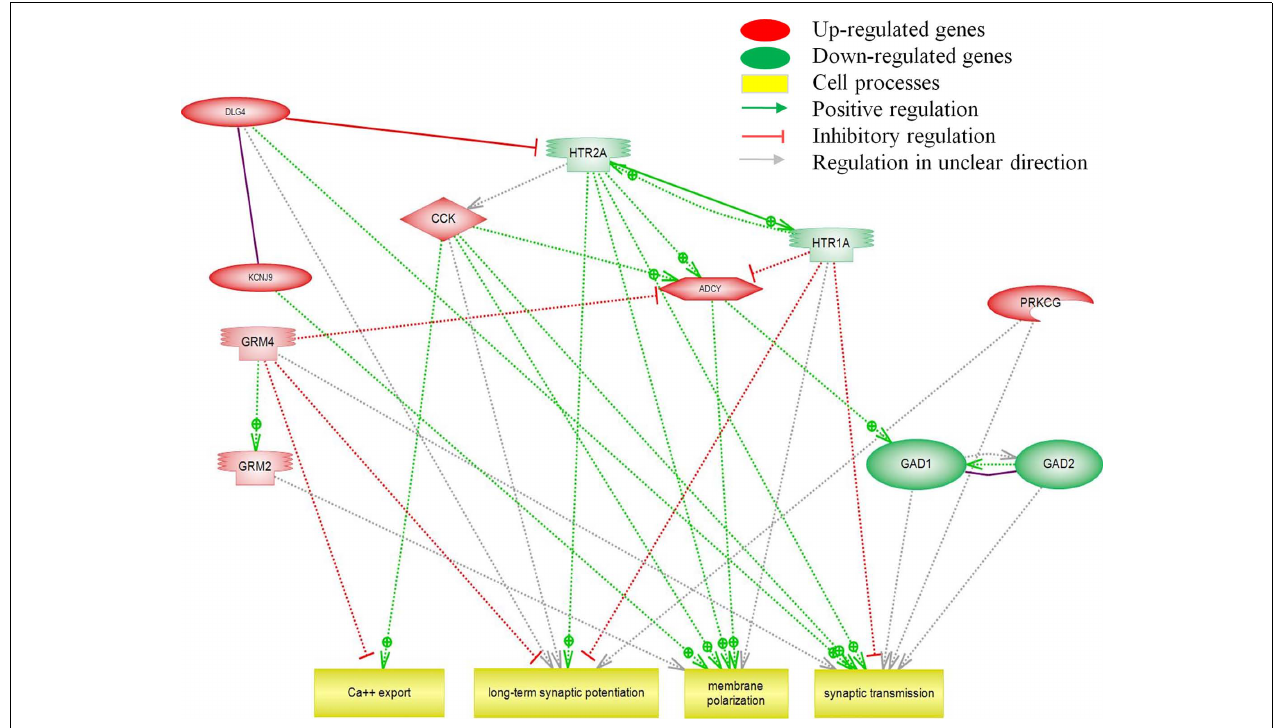
FIGURE 5 | Pathway analysis of transcripts ( p < 0.05) involved in cell